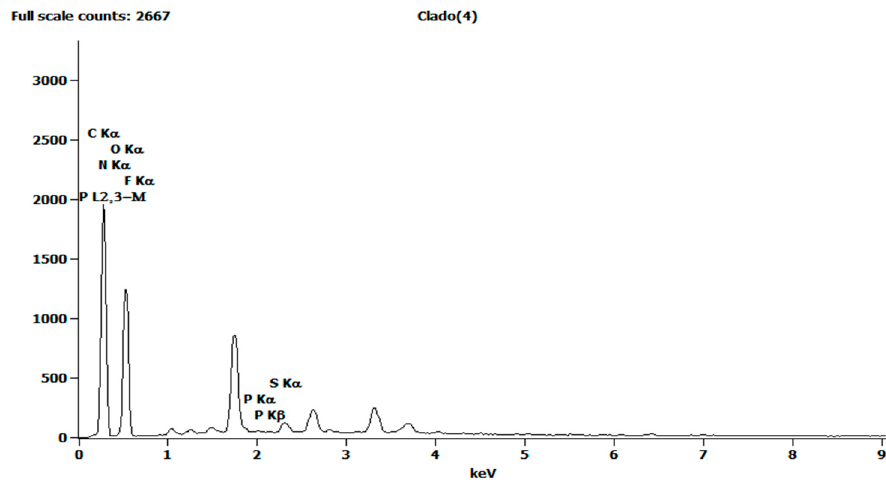
Figure 3. EDS spectra of phragmites biomass powder.